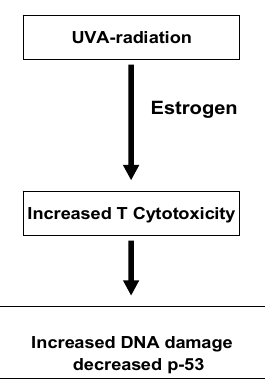
This figure represents the mechanism of action of estrogen. Under the influence of UVA radiation estrogen causes increased T cytotoxicity which results in increased DNA damage and decreased